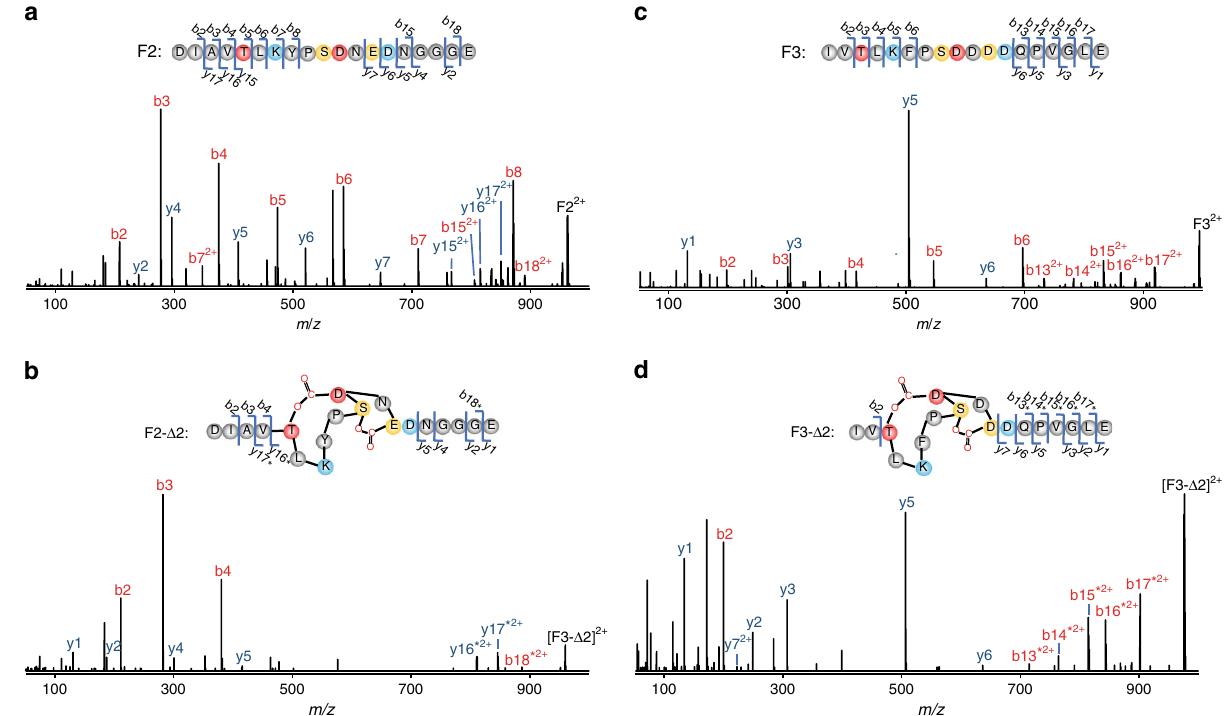
Fig. 3 Structural determination of AMdnA- Δ 5 by HR tandem MS analysis. a HR-MS/MS spectrum of the released F2 of intact AMdnA. b HR-MS/MS spectrum of the released F2- Δ 2 of processed AMdnA. c HR-MS/MS spectrum of the released F3 of intact AMdnA. d HR-MS/MS spectrum of the released F3- Δ 2 of processed AMdnA. The samples were treated with GluC for 16 h. Macrolactonizations on the M2 and M3 prevented the formation of multiple fragments from the corresponding regions of F2- Δ 2 and F3- Δ 2